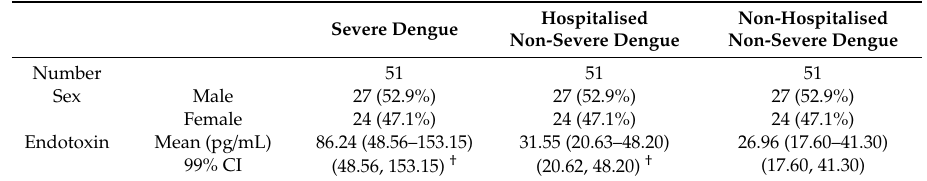
Table 3. The association of serum endotoxin levels and dengue disease severity with comparison of SD, Hospitalised Non-SD and Non-hospitalised Non-SD patients. Severe